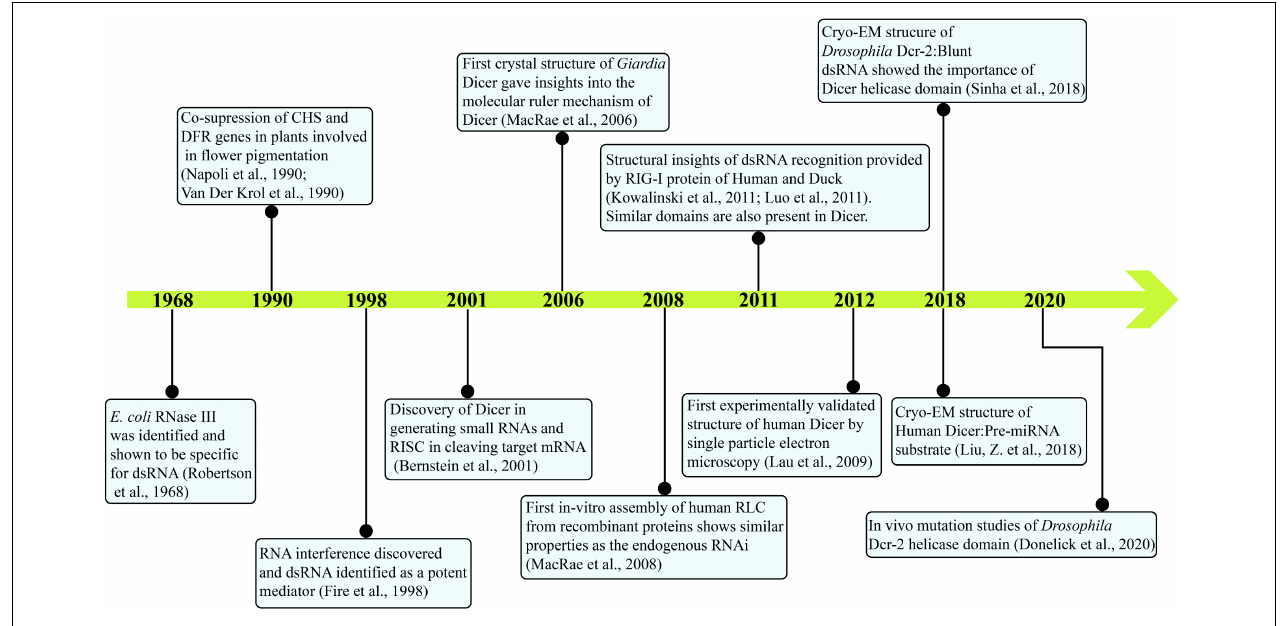
FIGURE 1 | Major events in the timeline of Dicer research. Current knowledge on Dicer is attained by research from several groups and is annotated. With the identification of E. coli RNase III in 1968 to the present day, cryo-EM structures of Hs Dcr and Dm Dcr-2 depict the intricate work carried out through decades.